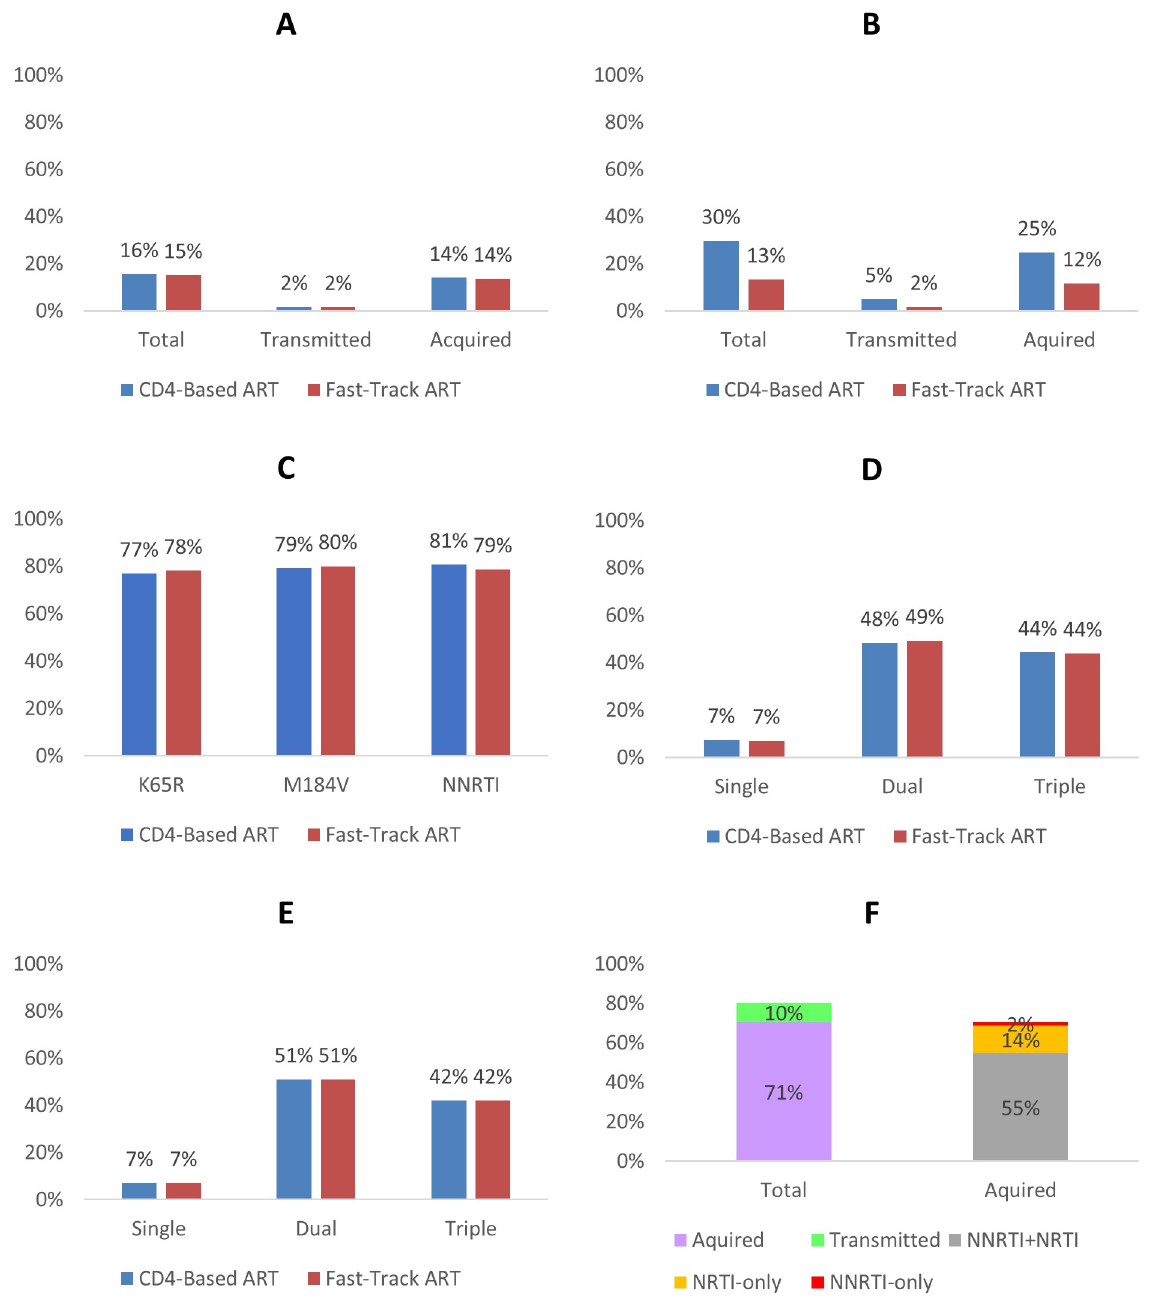
Fig 3. Prevalence of total, acquired and ART-adjusted HIV drug resistance. A: Prevalence of total drug resistance at 2018. B: Prevalence of total drug resistance by 2030. C: Prevalence of acquired drug resistance mutations by 2030. D: Prevalence of acquired drug-resistant mutants by 2030. E: Prevalence of acquired drug-resistant mutants at 2018. F: ART-adjusted drug resistance prevalence at 2018.